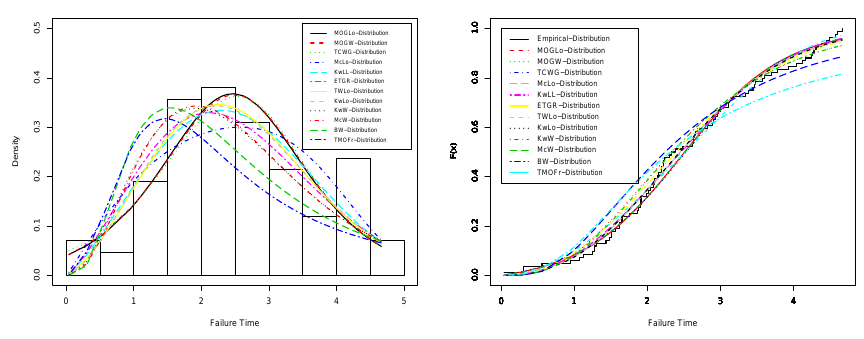
Figure 6 – Fitted pdfs (left panel) and cdfs (right panel) for windshield